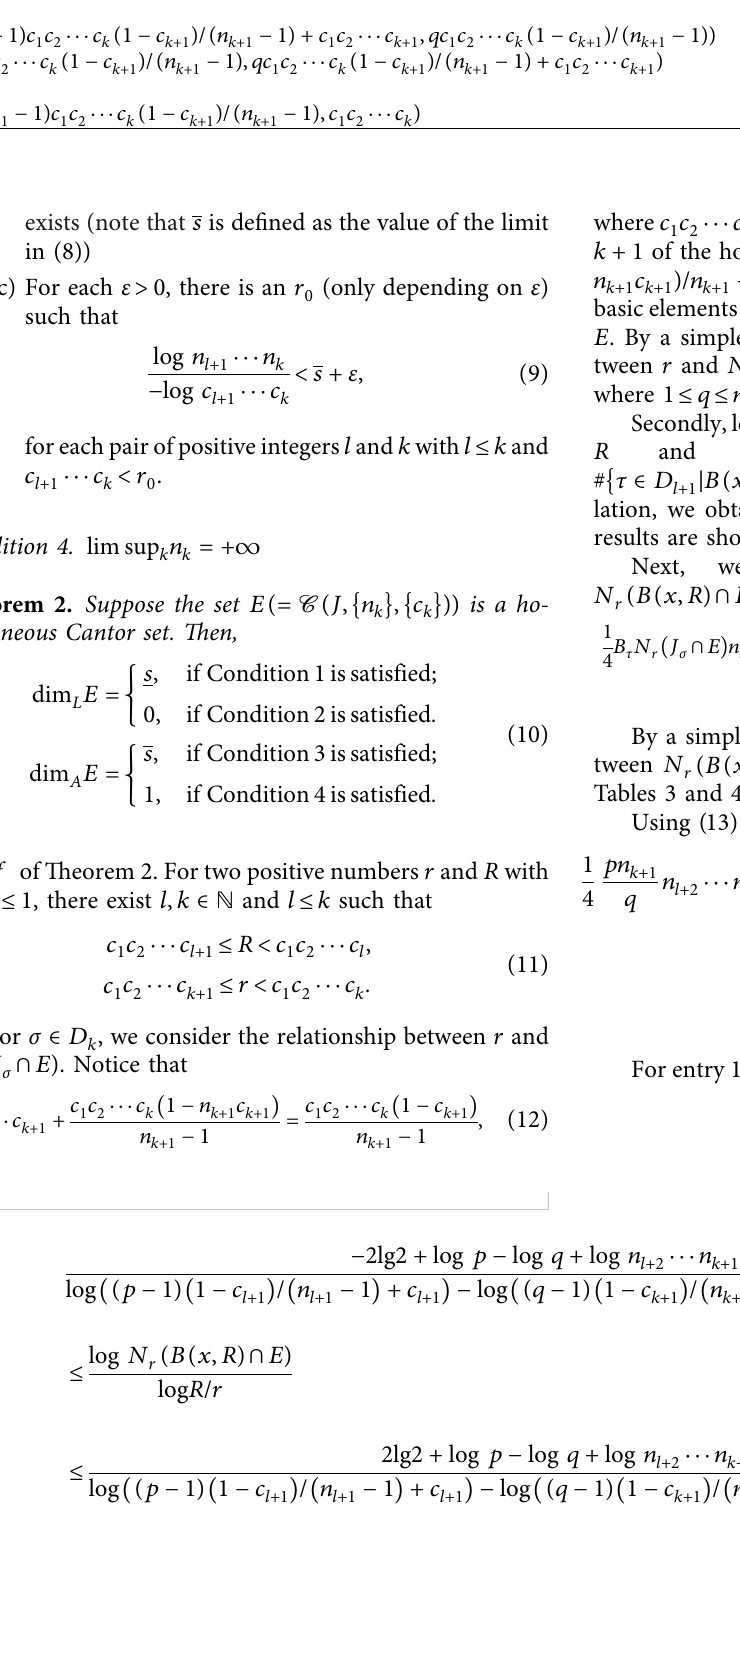
Table 1: The calculation of N